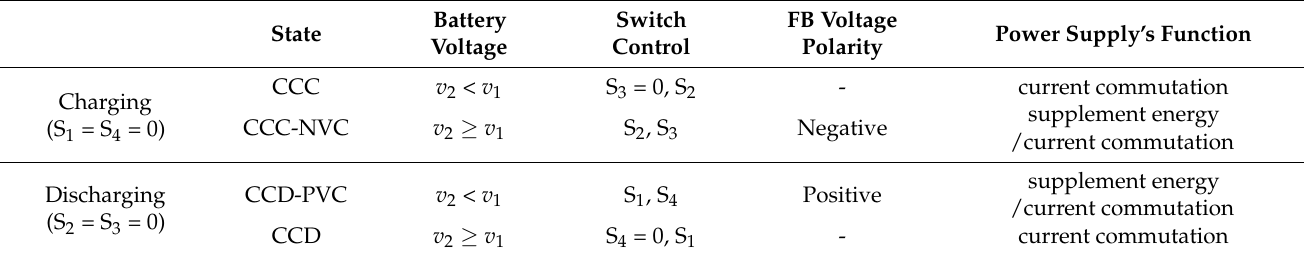
Table 1. State and control